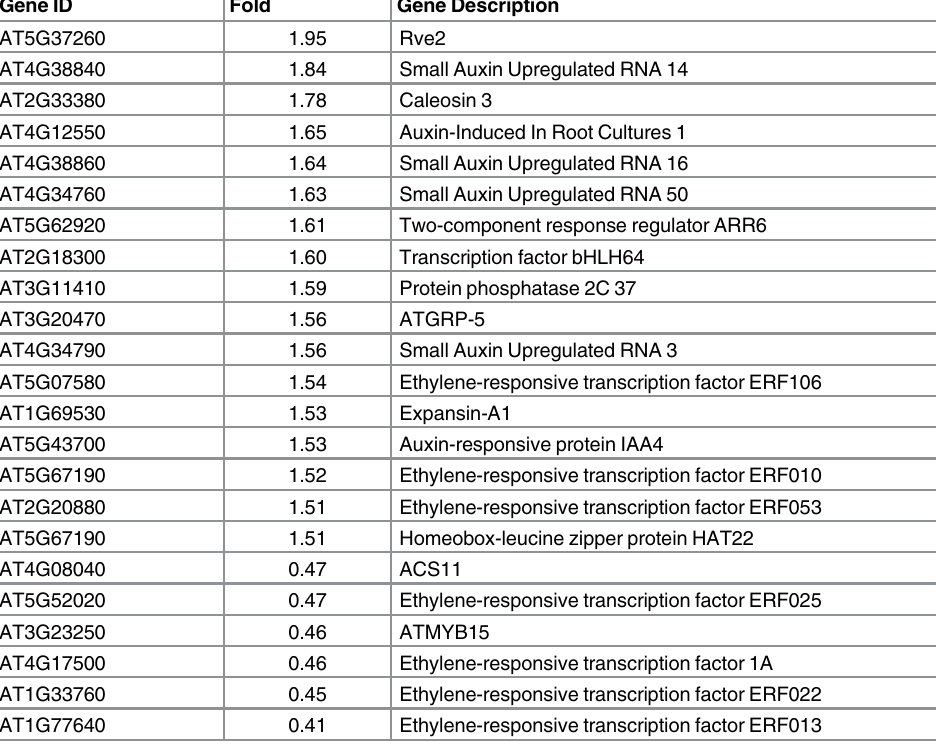
down, or showing disrupted regulation (either up or down) was determined by DAVID (Data- base for Annotation, Visualization and Integrated Discovery) analysis with the A. thaliana genome background[18]. Microarray data is available from ArrayExpress (https://www.ebi.ac. uk/arrayexpress/). Table 2. Selected hormone related genes disrupted by BPA. Analysis by DAVID. Gene ID Fold Gene